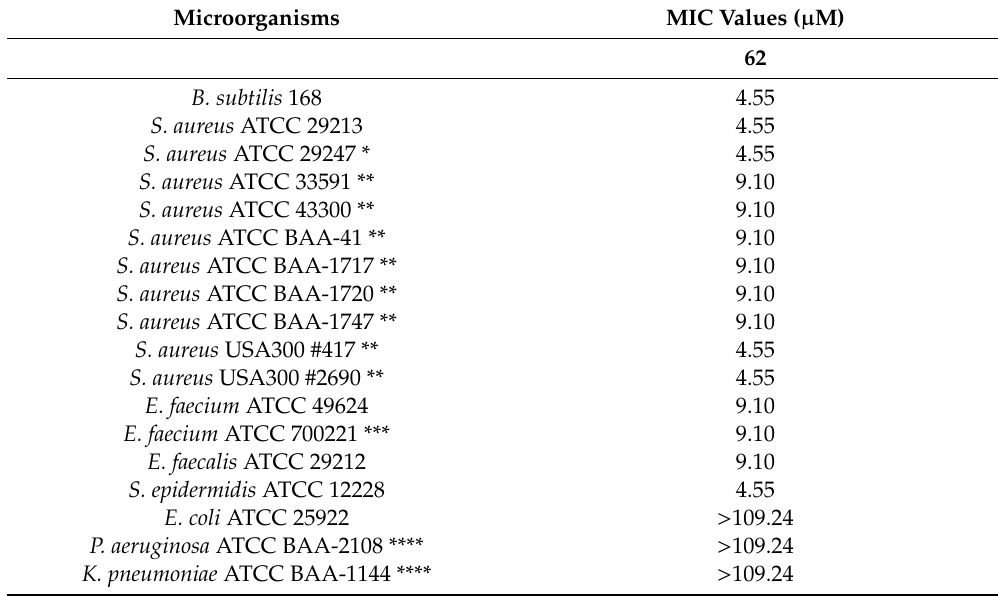
Table 13. MIC values of tiplaxtinin ( 62 ) on Gram-positive and Gram-negative bacteria.